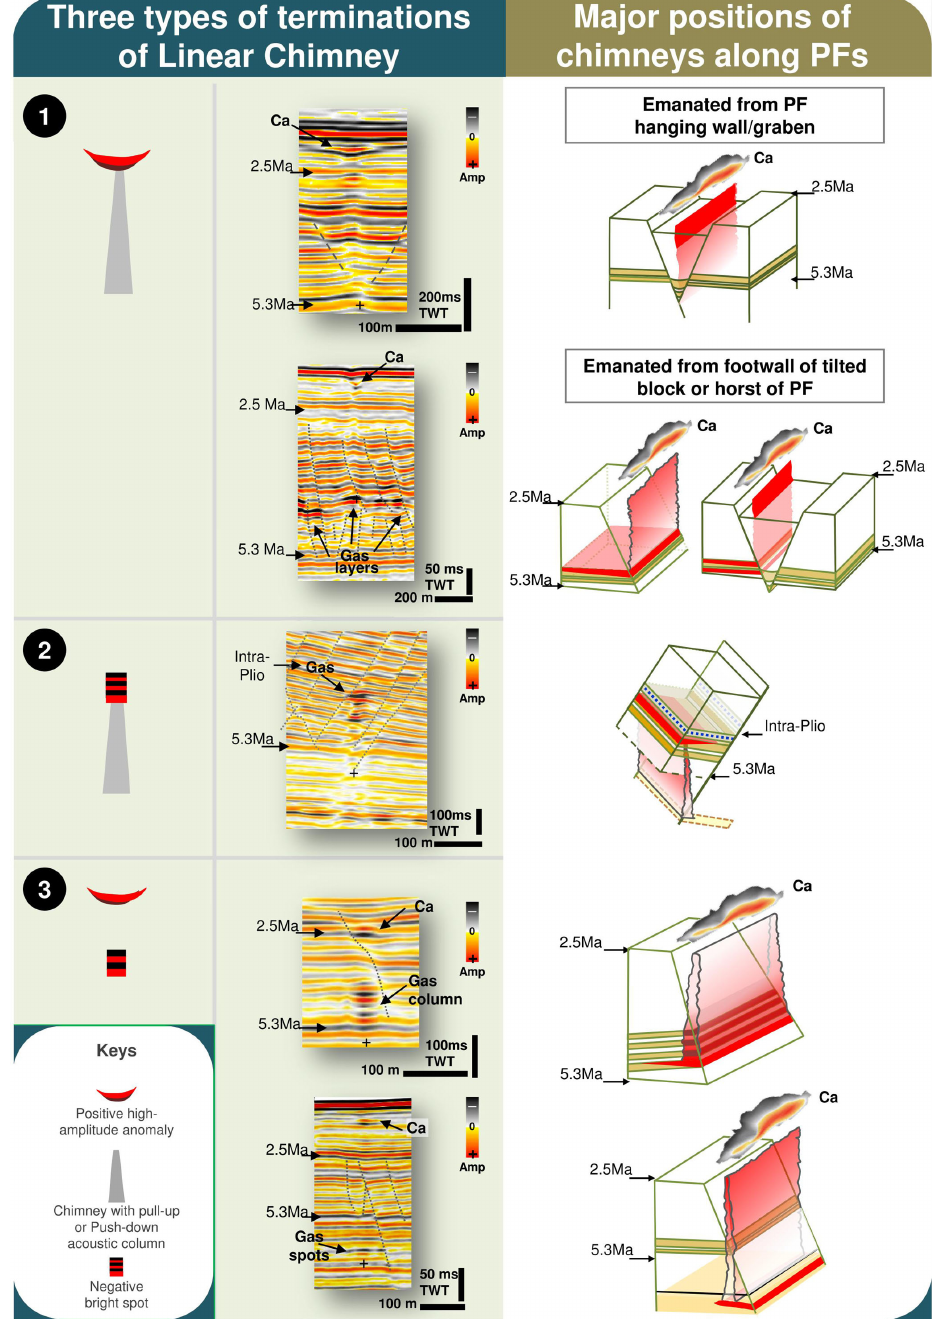
Figure 8. Classification scheme showing types of terminations of Linear Chimneys. Left column: symbols which represent the three groups of Linear Chimneys with different upward and downward terminations. Middle column: the seismic images of the chimneys represented by the symbols. The apparent bases of chimneys are marked with crosses. Right column: the 3-D interpretation of the major intersecting positions between the polygonal faults and the Linear Chimneys shown in the adjacent seismic images.